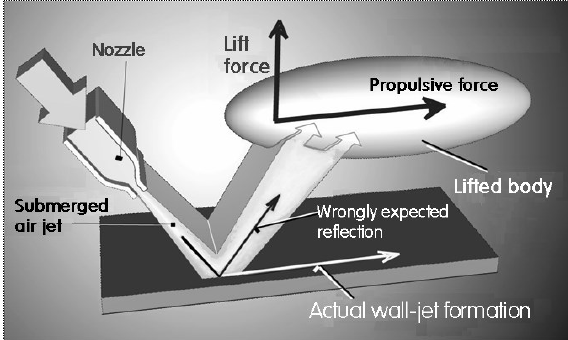
Fig. 1. Wrong idea of transporting by an air jet a small body propelled and lifted by the jet "reflected" from the wall.